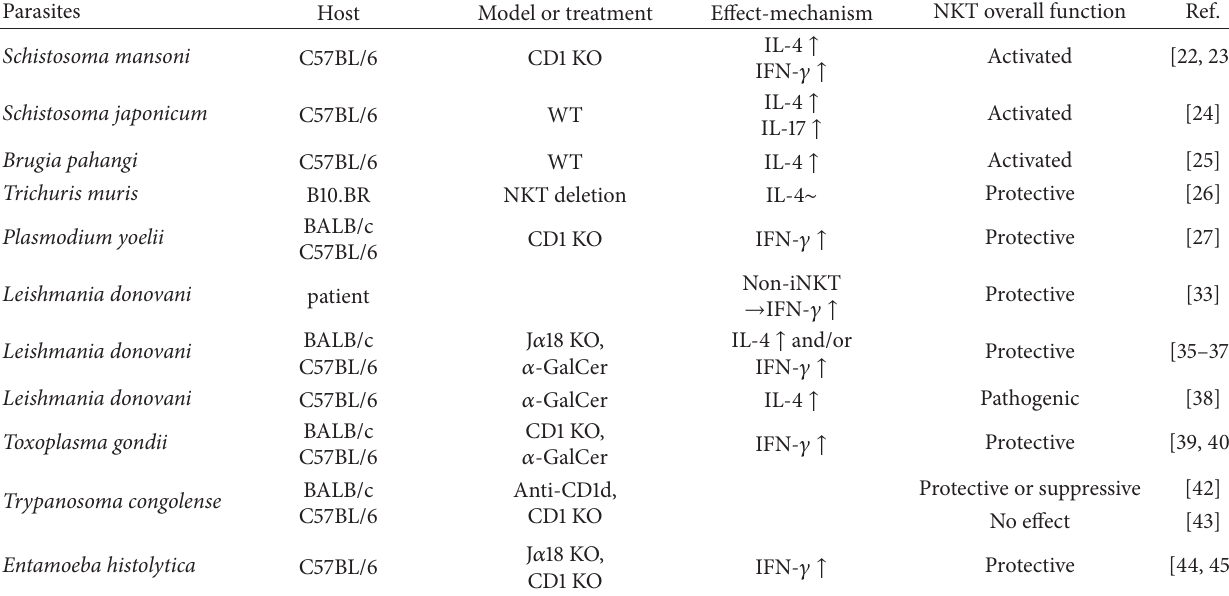
Table 2: Summary of NKT cells on parasite